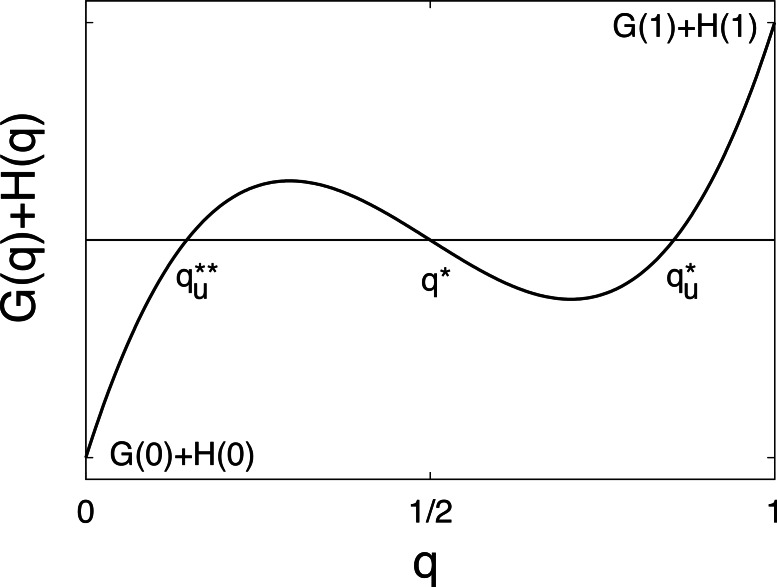
Function G(q) + H(q) on a schematic figure with singular points \documentclass[12pt]{minimal}
\usepackage{amsmath}
\usepackage{wasysym}
\usepackage{amsfonts}
\usepackage{amssymb}
\usepackage{amsbsy}
\usepackage{upgreek}
\usepackage{mathrsfs}
\setlength{\oddsidemargin}{-69pt}
\begin{document}
}{}${x}_{u}^{\ast \ast }$\end{document}xu∗∗, xu and \documentclass[12pt]{minimal}
\usepackage{amsmath}
\usepackage{wasysym}
\usepackage{amsfonts}
\usepackage{amssymb}
\usepackage{amsbsy}
\usepackage{upgreek}
\usepackage{mathrsfs}
\setlength{\oddsidemargin}{-69pt}
\begin{document}
}{}${x}_{u}^{\ast }$\end{document}xu∗, when (Eq. (28)) are valid.